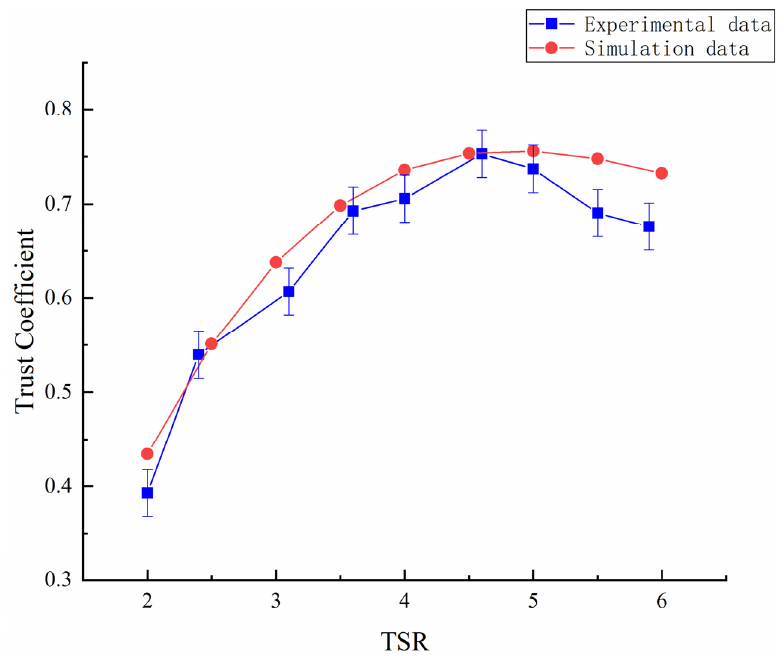
Figure 15. Comparison of experimental data and simulation data of the trust coefficient.